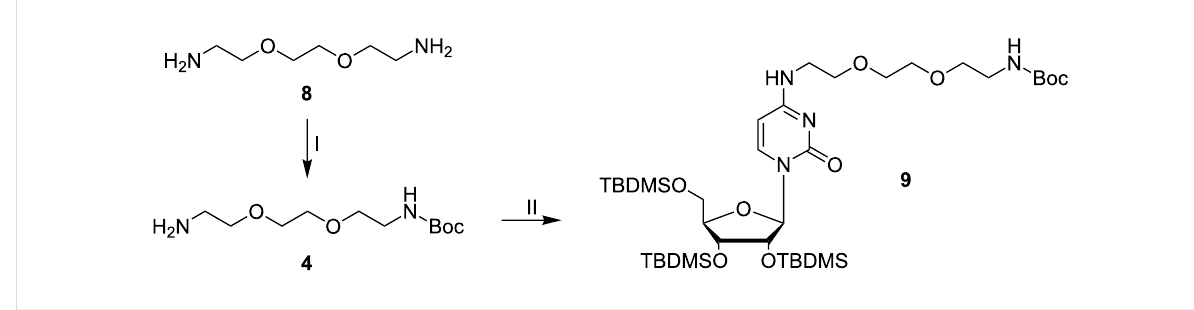
Figure 3: Preparation of synthon 4 and substitution of the triazolyl moiety of 3 to form the fully protected cytidine derivative 9 . I: 0.16 equiv Boc 2 O, dioxane, 3 h, rt, 68% (based on the amount of Boc 2 O); II: 0.77 equiv triazolyl protected uridine 3 , MeCN, rt, overnight, 85%.